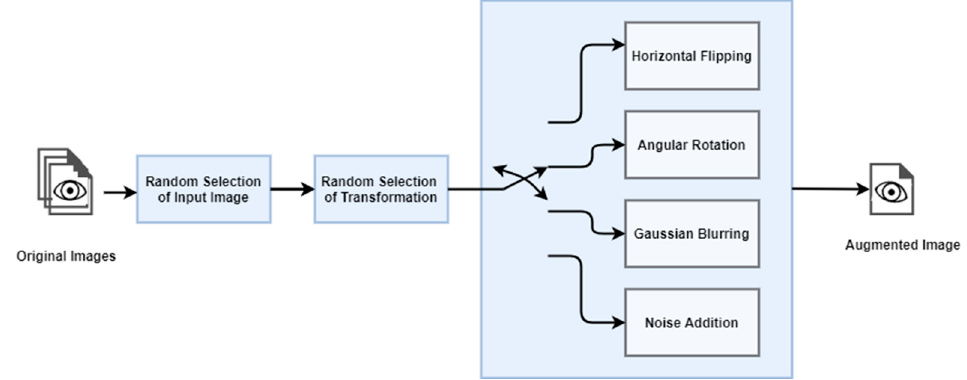
Figure 2. Augmentation model for the U-Net based conjunctiva segmentation model (UNBCSM). Vertical flipping, contrast enhancement, and warp shifting transformation techniques are also